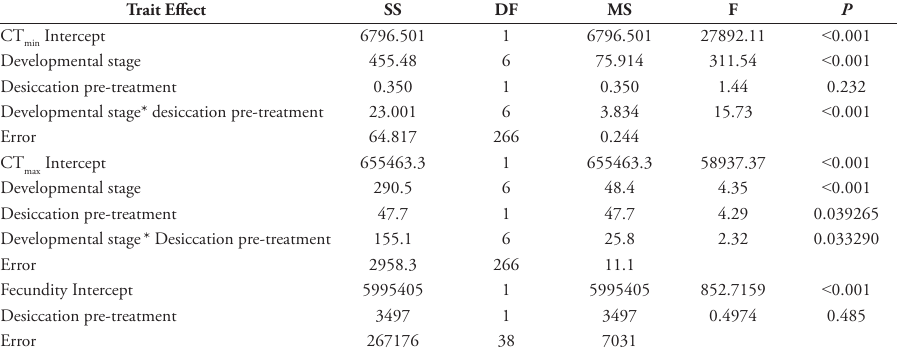
Table 3. Summary statistical results from a factorial ANOVA (CT and CT ) and one-way ANOVA min max (fecundity) showing effects of desiccation pre-treatment, developmental stage and interaction thereof on S. frugiperda critical thermal limits (CT , CT ) (larvae and adults) and adult fecundity, measured as min max number of 1 st instar neonates larvae produced during a 7 days incubation period. SS = sums of squares, DF = degrees of freedom, CT = critical thermal minimum, CT = critical thermal min max